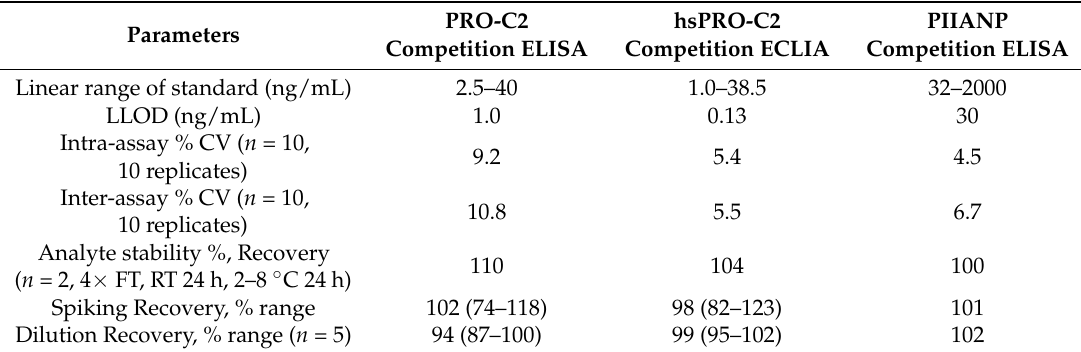
Table 1. Summary of technical performance for three biomarker